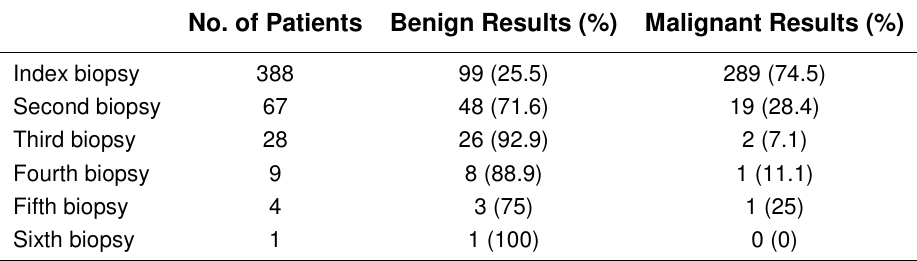
Patients with PSA at Least 20 ng/ml Biopsied from 1997 to 2002 No. of